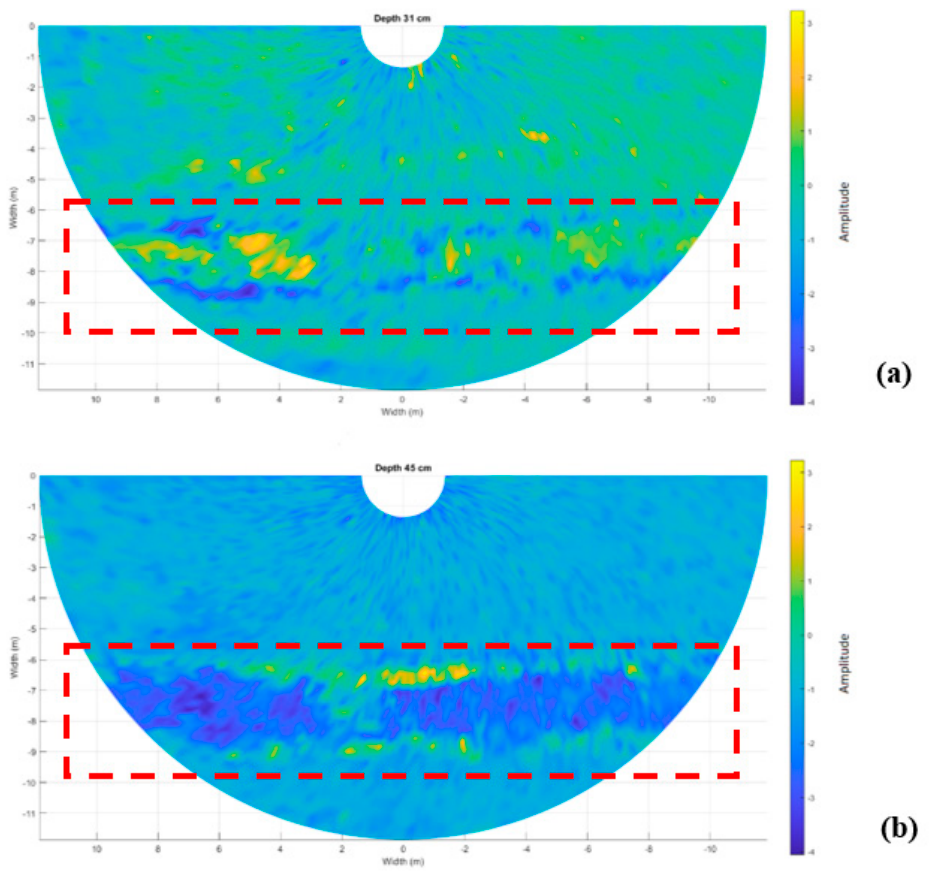
Figure 9. C-scans of the investigated area at ( a ) 0.31 m of depth and ( b ) 0.45 m of depth. The red dashed areas clearly show the presence of a buried structure.